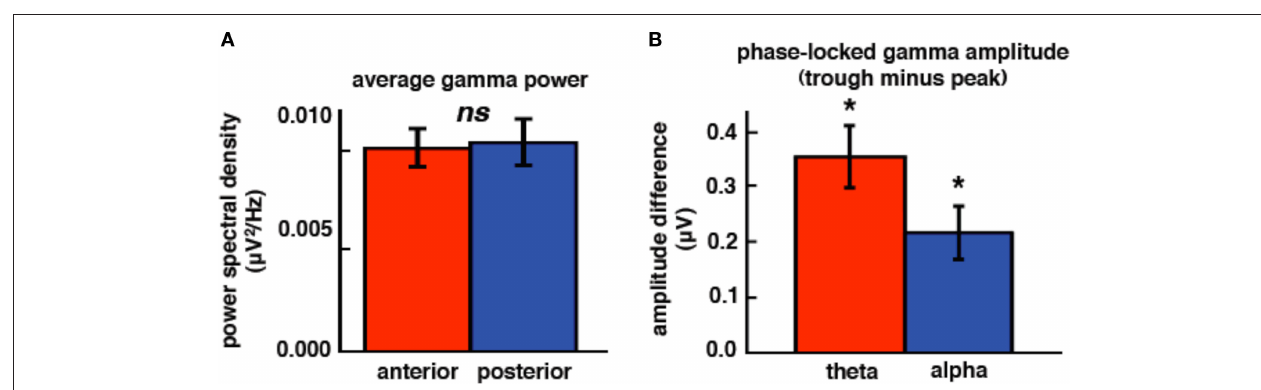
compared to anterior sites. (C) ECoG subjects exhibited a similar pattern of power distribution by topography where alpha power increases over posterior electrode sites relative to anterior alpha power (combined data). All power values are shown as log(power) across frequency bands. * p < 0.0005, ** p = 0.019 ( t -tests).